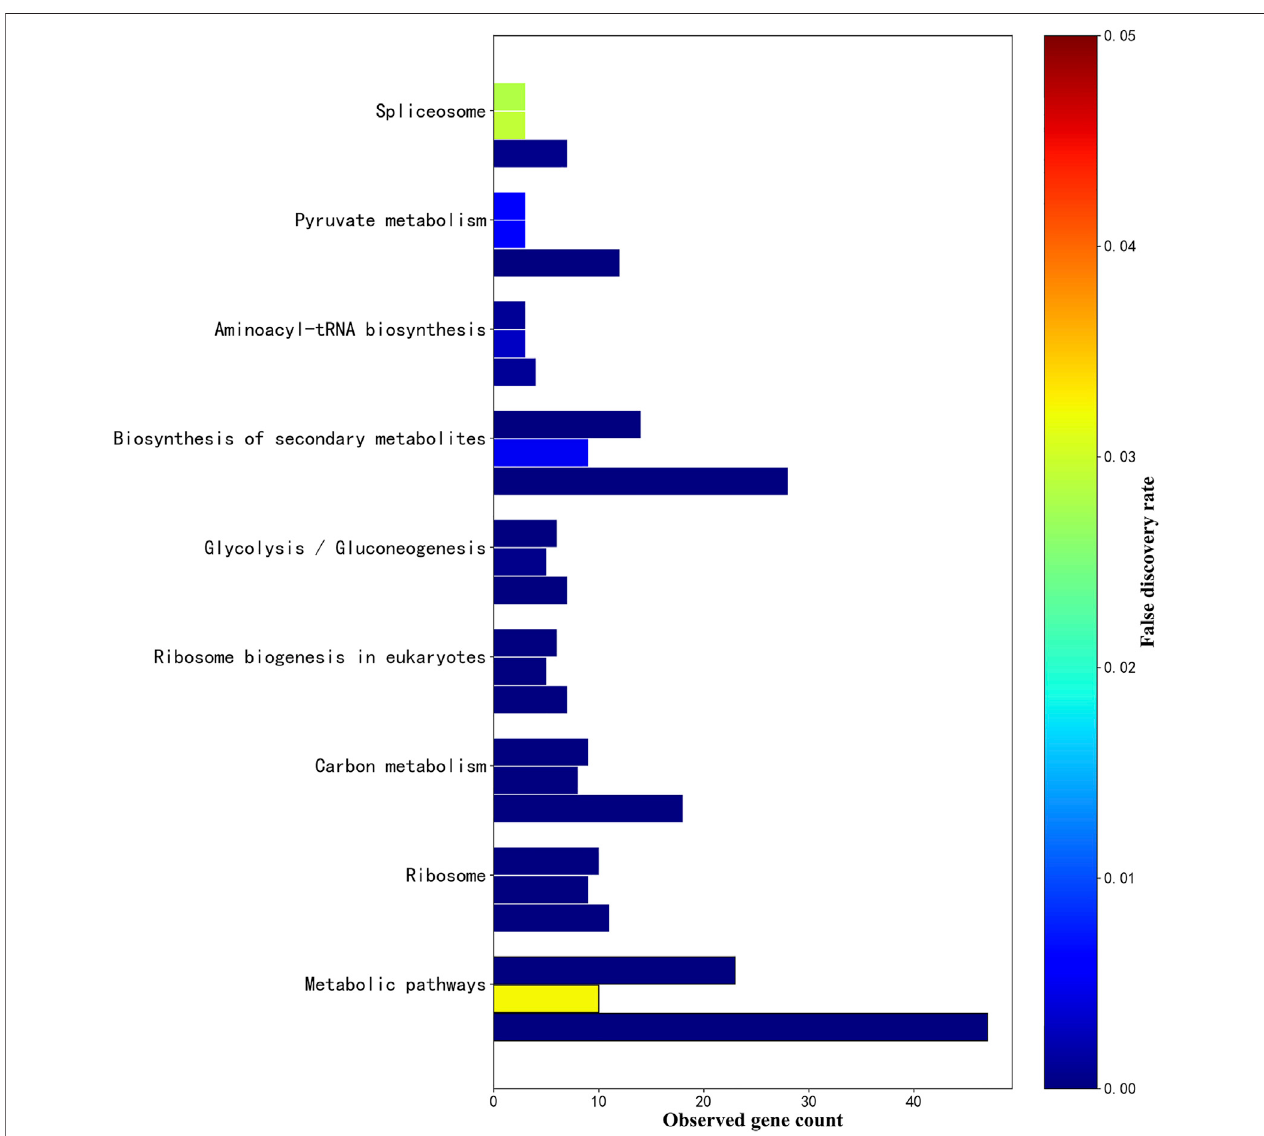
FIGURE 8 | . KEGG_pathway parallel histogram of three fungal sRNA targeting. The fi gure above shows 9 KEGG_Pathways that co-exist in Phytophthora infestans , Magnaporthe oryzae and Botrytis cinerea . The upper bar graph is the KEGG_Pathway targeted by Phytophthora infestans sRNA, the bar in the middle is Magnaporthe oryzae ,andthelowerbargraphistheKEGG_Pathwaytargetedby Botrytiscinerea sRNA.The x -axisisthenumberofgenesobservedinthepathway.The y -axisinthe fi gure is sorted in ascending order of the false discovery rate of Phytophthora infestans . The color of the false discovery rate is displayed in the right label.